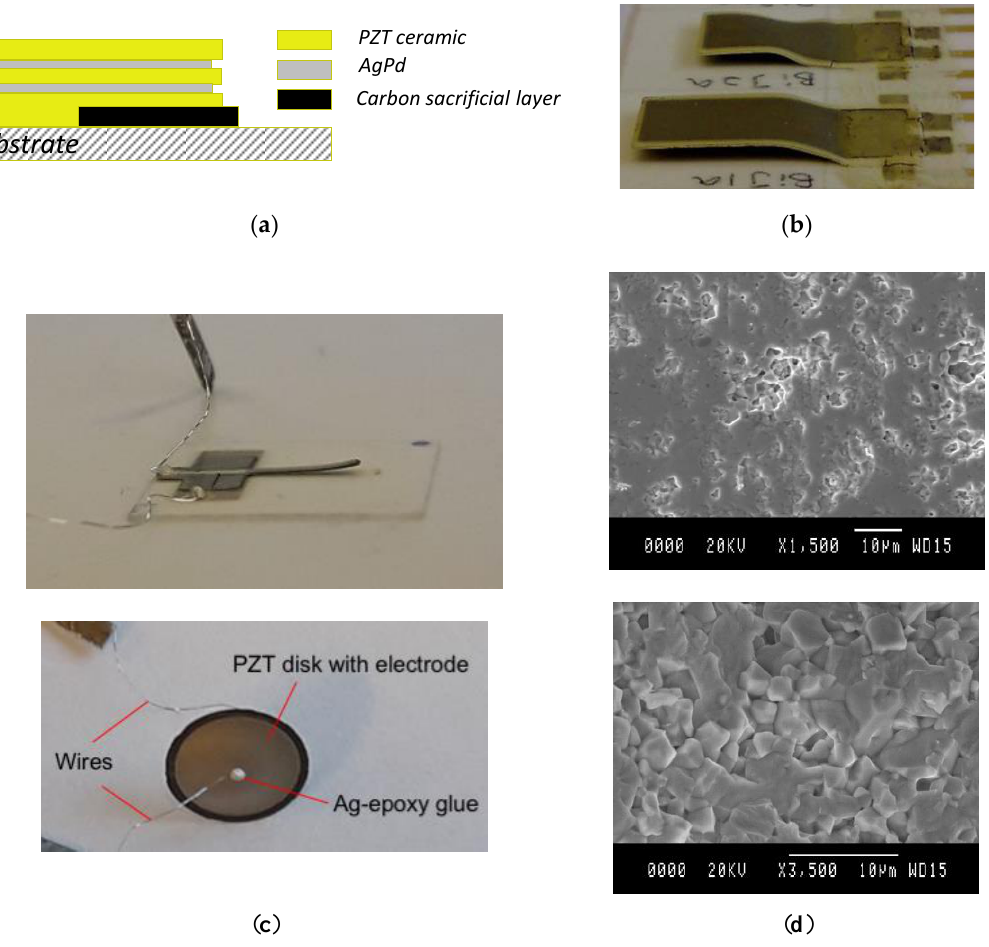
Figure 6. Photographs and SEM images of PZT free-standing devices. ( a ) Assembly scheme (inspired from [49]) ( b ) photograph of a free-standing cantilever (carbon sacrificial layer). Reproduced with permission from [9], copyright 2009 IOP. ( c ) Au / PZT / Au cantilever and AgPd / PZT / AgPd disks (polyester sacrificial layer). ( d ) SEM images of PZT printed on a polyester sacrificial layer: Upper image: Polished cross section; lower image: Fractured